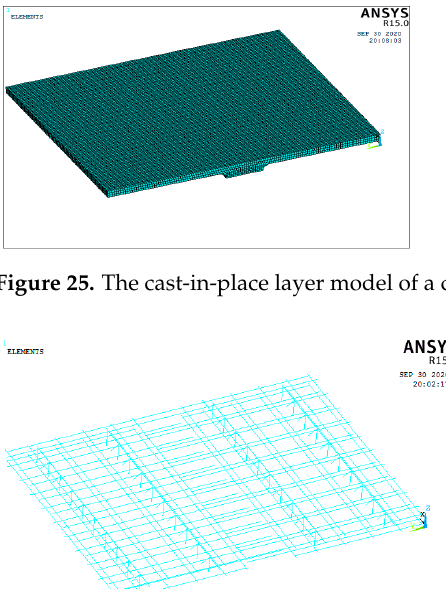
Figure 26. The steel grid model of a composite slab.